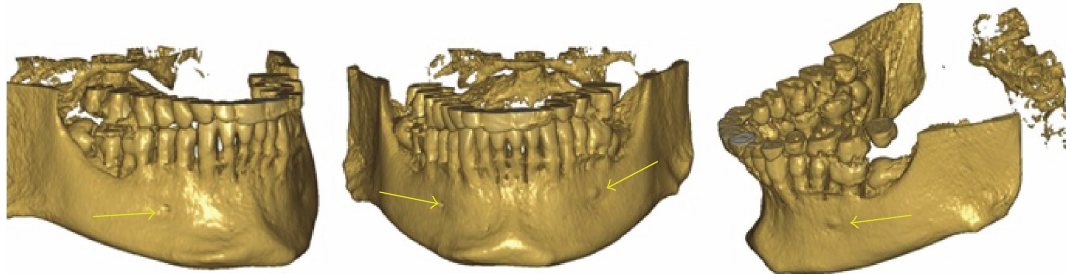
Figure 4: 3D reconstruction of the patient’s right side, left side, and frontal appearance showing hypoplastic foramen and protuberance at the MF area.